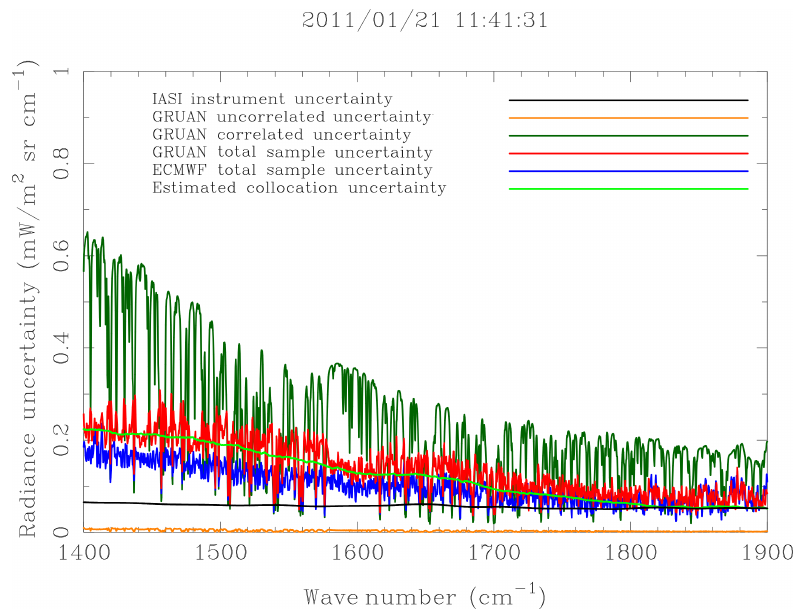
Figure 5. Several radiance uncertainties. IASI overall instrument uncertainty (black); GRUAN instrument uncertainty propagated into ra- diance space assuming no uncertainty correlation between levels for the 21 January 2011 at 11:41:31 case (orange); GRUAN instrument uncertainty propagated into radiance space assuming perfect uncertainty correlation between levels for the 21 January 2011 at 11:41:31 case (dark green); calculated radiance standard deviation from GRUAN sondes for all the completely clear sky scenes and night-time cases (red); calculated radiance standard deviation from ECMWF profiles for all the clear-sky scenes and night-time cases (blue); estimated collocation uncertainty plus any remaining RTM uncertainties (light